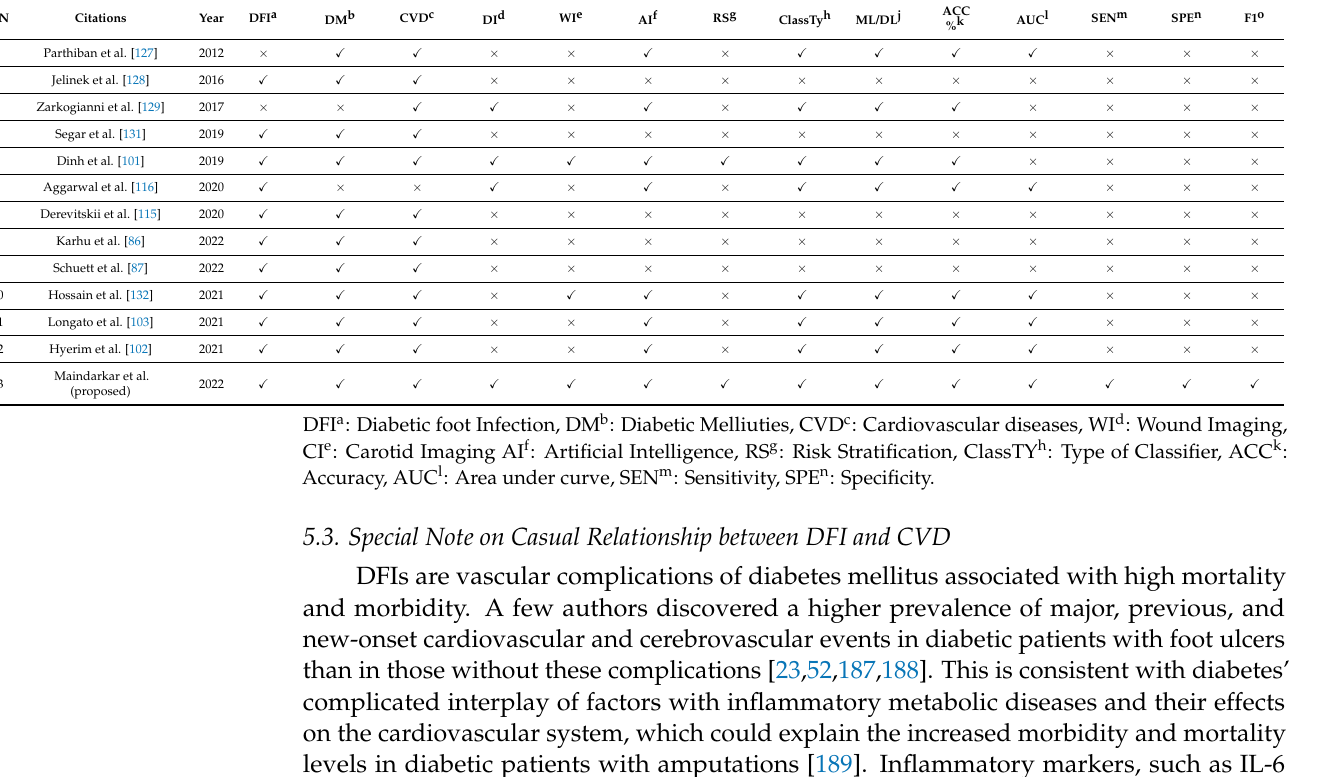
Table 3. Comparing the proposed review against previous reviews on joint DFI and CVD.